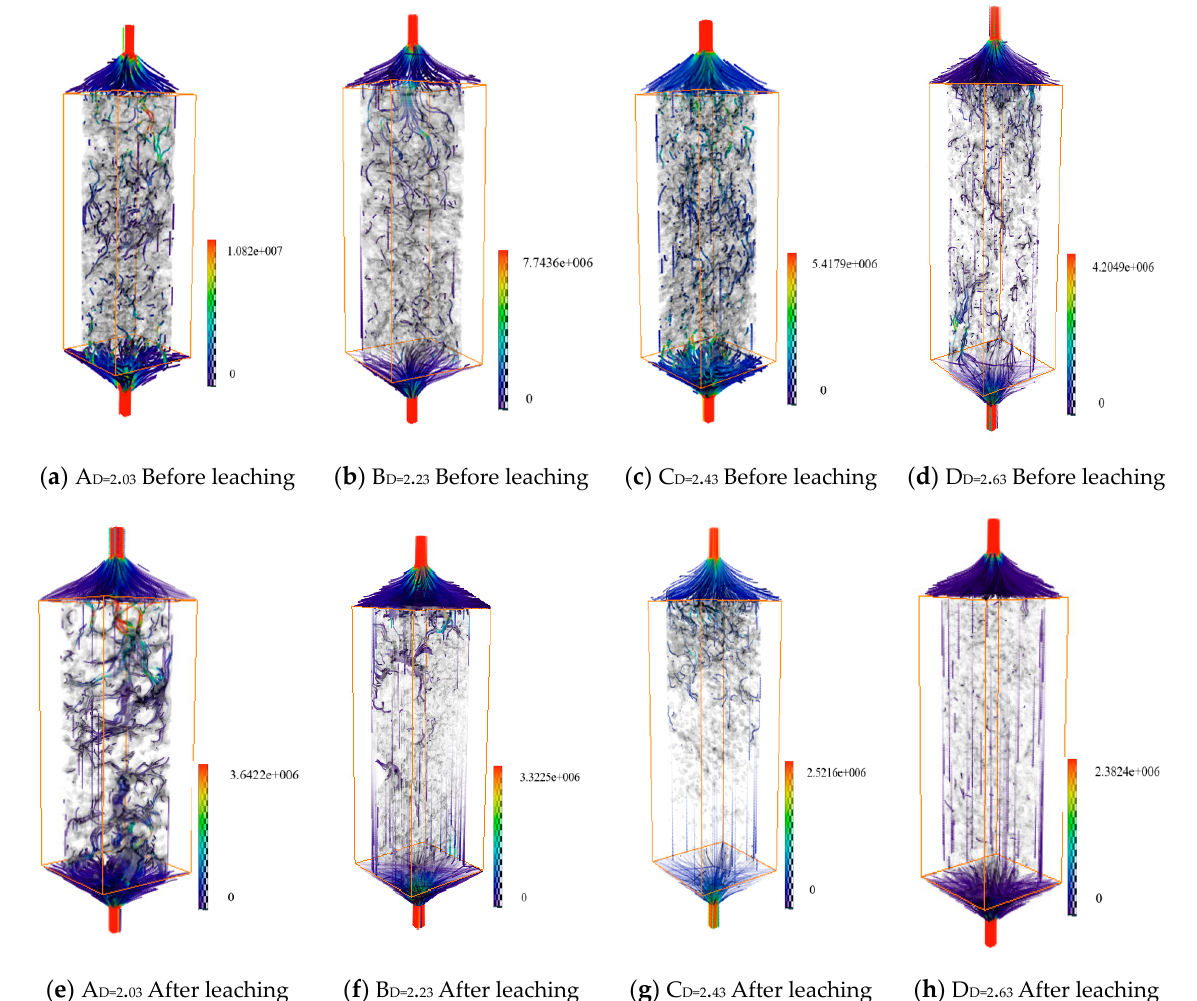
Figure 14. Distribution characteristics of the seepage path of the solution in ore samples during leaching. ( a ) A D = 2 . 03 Before leaching; ( b ) B D = 2 . 23 Before leaching; ( c ) C D = 2 . 43 Before leaching; ( d ) D D = 2 . 63 Before leaching; ( e ) A D = 2 . 03 After leaching; ( f ) B D = 2 . 23 After leaching; ( g ) C D = 2 . 43 After leaching; ( h ) D D = 2 . 63 After leaching.